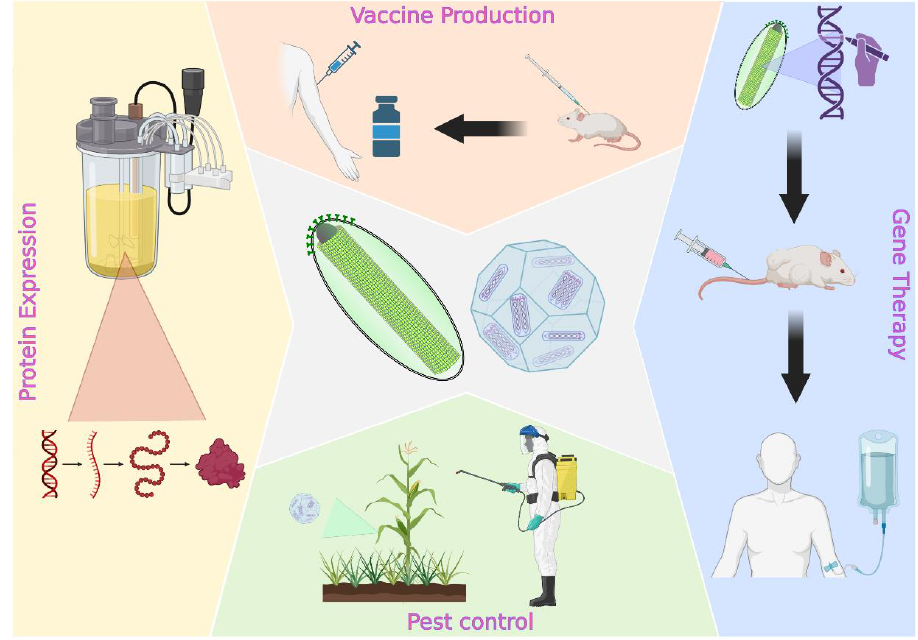
Figure 1. Schematic representation of main applications for baculovirus-based technologies. Cre- ated with BioRender.com, ( accessed on 29 of November 2022) . with BioRender.com, (accessed on 29 November